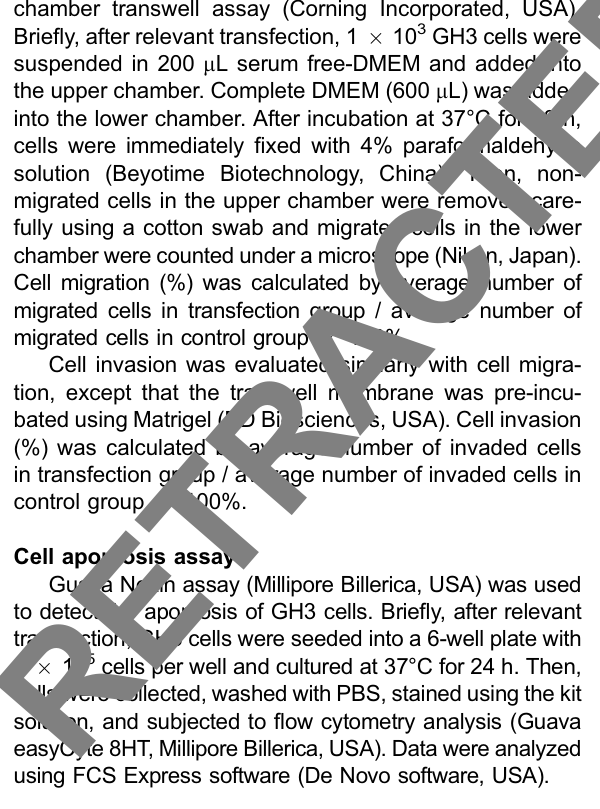
Figure 1. Highly up-regulated in liver cancer (HULC) was highly expressed in GH3 cells. The expression level of HULC in rat pituitary primary cells (PPC) and rat secreting pituitary adenoma GH3 cells was detected using qRT-PCR. Data are reported as means ± SD. ** P o 0.01